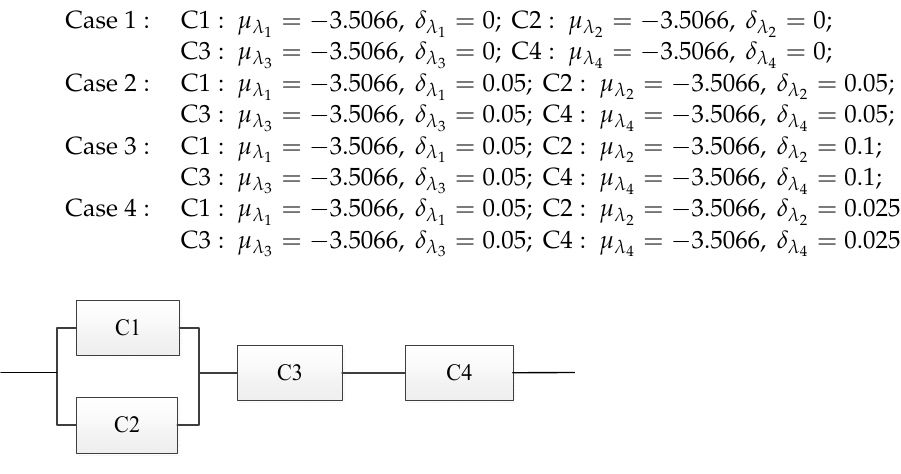
Figure 4. A series-parallel